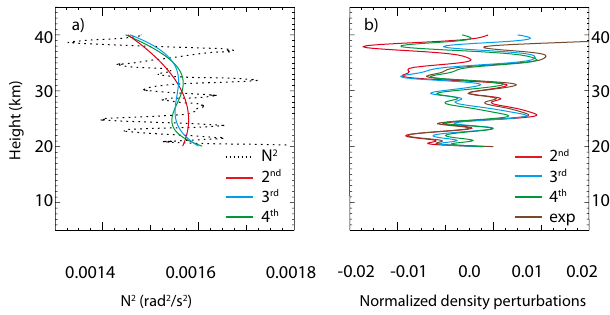
Figure 3. a) Various (polynomial) fits of the local buoyancy frequency squared ( N 2 ( z ) )in the 2 Figure 3. (a) Various (polynomial) fits of the local buoyancy fre- quency squared ( N 2 (z)) in the stratosphere, (b) corresponding nor- stratosphere, b) corresponding normalized density perturbations. 3 malized density